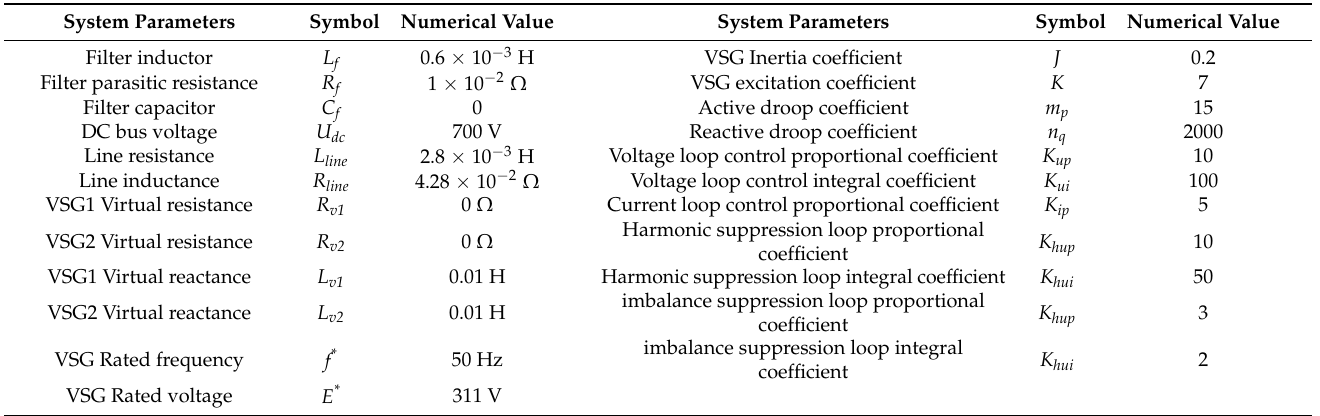
Table 1. Information of experimental parameters.